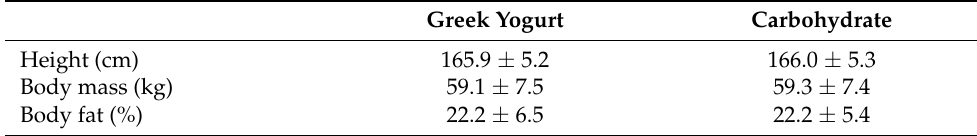
Table 1. Physical characteristics of the female soccer players (N = 13) at pre-training during each nutritional intervention. Values are mean ± standard deviation.